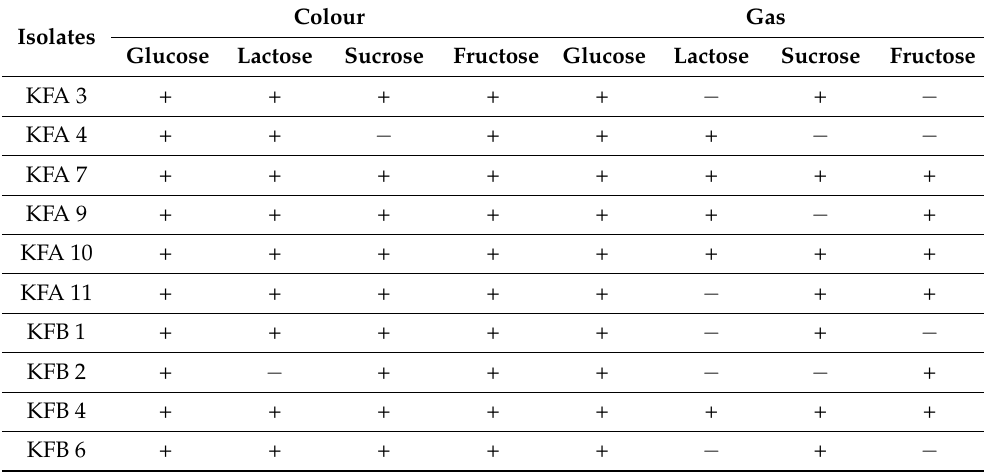
Table 1. Ability of yeast isolates to ferment different carbon sources. The ability of isolates to ferment different sugars was indicated by the presence of gas and change in the colour of media from green to yellow. Colour Gas Isolates Glucose Lactose Sucrose Fructose Glucose Lactose Sucrose Fructose KFA 3 + + + + + − + − KFA 4 + + − + + + − − KFA 7 + + + + + + + + KFA 9 + + + + + + − + KFA 10 + + + + + + + + KFA 11 + + + + + − + + KFB 1 + + + + KFB 2 + + + KFB 4 + + + KFB 6